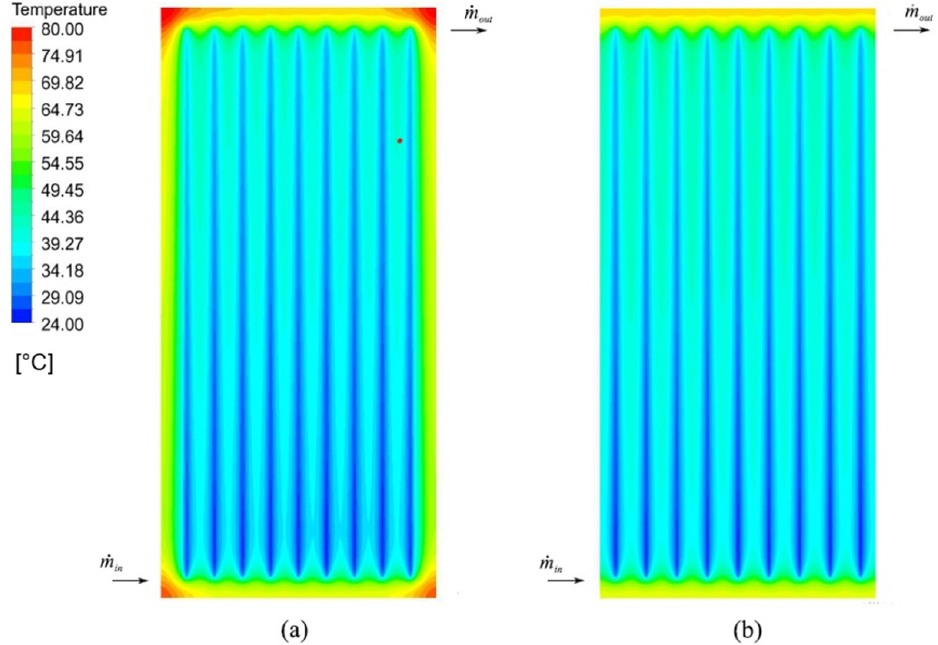
Figure 10. Temperature distribution on the surface of the solar collector absorber plate. ( a ) Standard solar collector; ( b ) solar collector with a modified spacing.